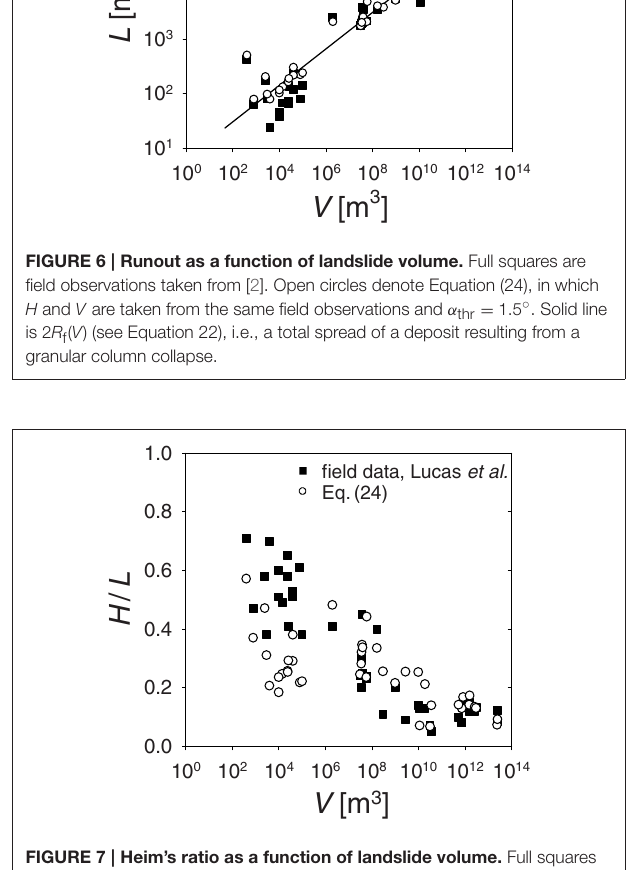
FIGURE 7 | Heim’s ratio as a function of landslide volume. Full squares are field observations taken from Lucas et al. [2]. Open circles are prediction based on Equation (24), in which H and V are taken from the same field observations and α thr 1.5 ◦ =